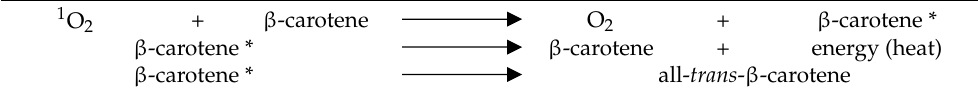
β -carotene * all- trans - β -carotene β -carotene * -triplet excited carotene.